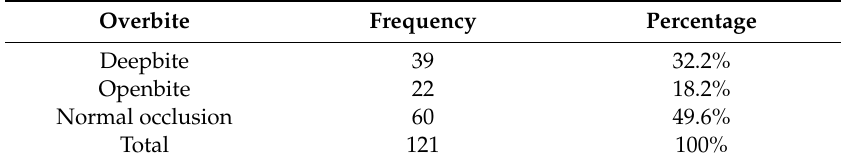
Table 4. Frequency and percentage of patients divided according to the depth of the bite, excluding non-valuable subjects.